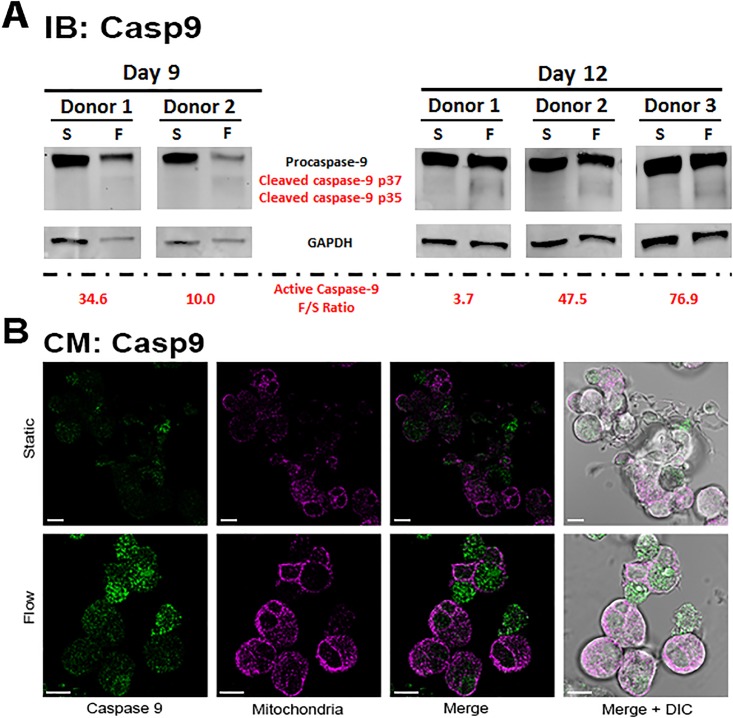
Caspase 9 activation in Mks is enhanced upon shear-flow exposure.A, Expression of active (cleaved) Caspase 9 expression from d9 and d12 Mks was quantified via immunoblot (Western-blot) analysis. Quantification was performed by Image J with normalization to expression of GAPDH, a reference protein. B, Confocal microscopy of representative d12 Mks before (top row) and after (bottom row) shear-flow exposure. Green: active Caspase 9, Pink: MitoTracker. Scale bar: 10μm.